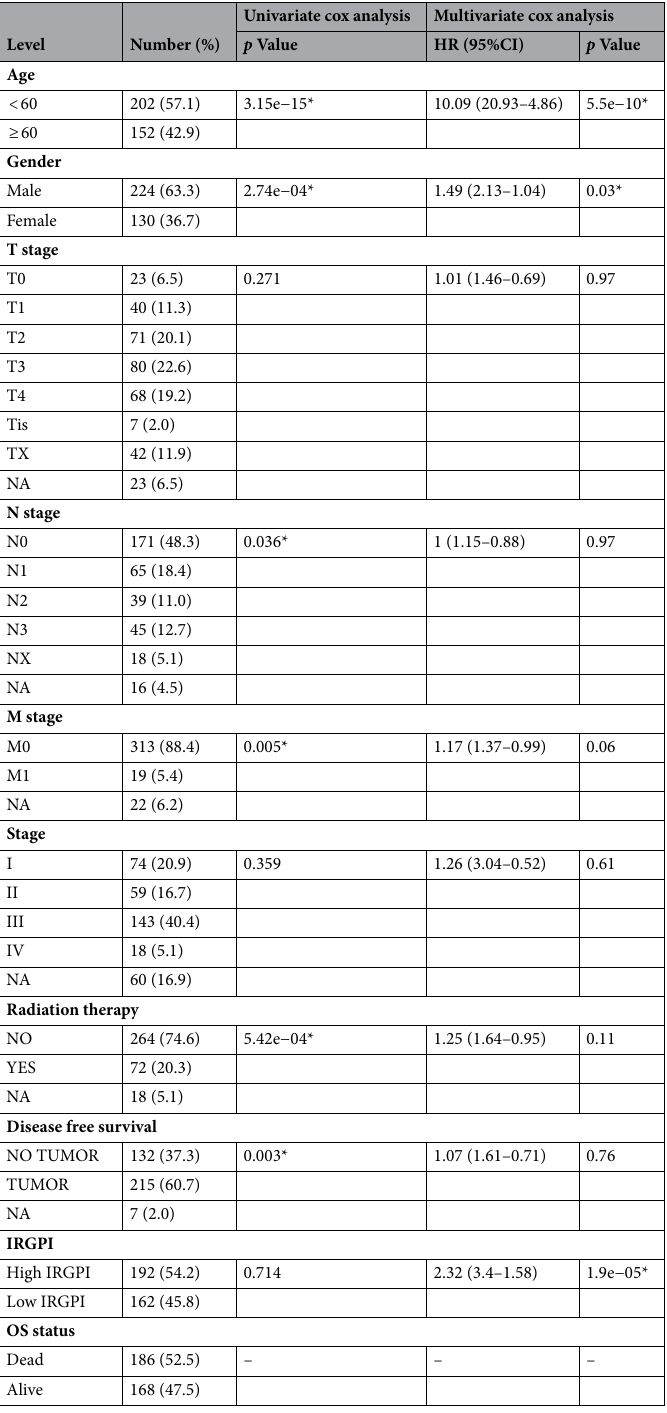
Table 1. The detail clinical features and the results of univariate and multivariable Cox regression analyses in training cohort. Abbreviation: HR hazard ratio, CI confidential interval, IRGPI immune-related gene pairs index, OS overall